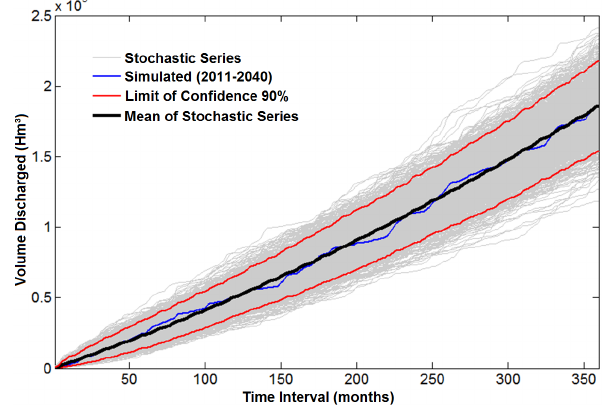
Figure 3. Curves of volume discharged in the future (2011– 2040) – difference between the original series (simulated) and the 1000 stochastic series generated – Ijuí River basin, Santo Ângelo gauge